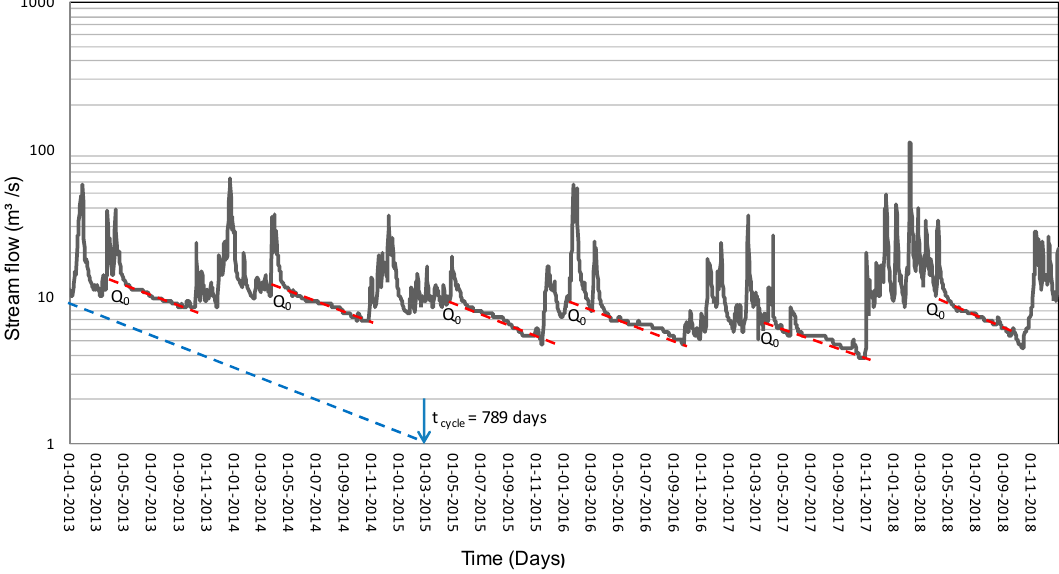
Figure 11. Spatial distribution of groundwater recharge potential in the Pandeiros River basin.